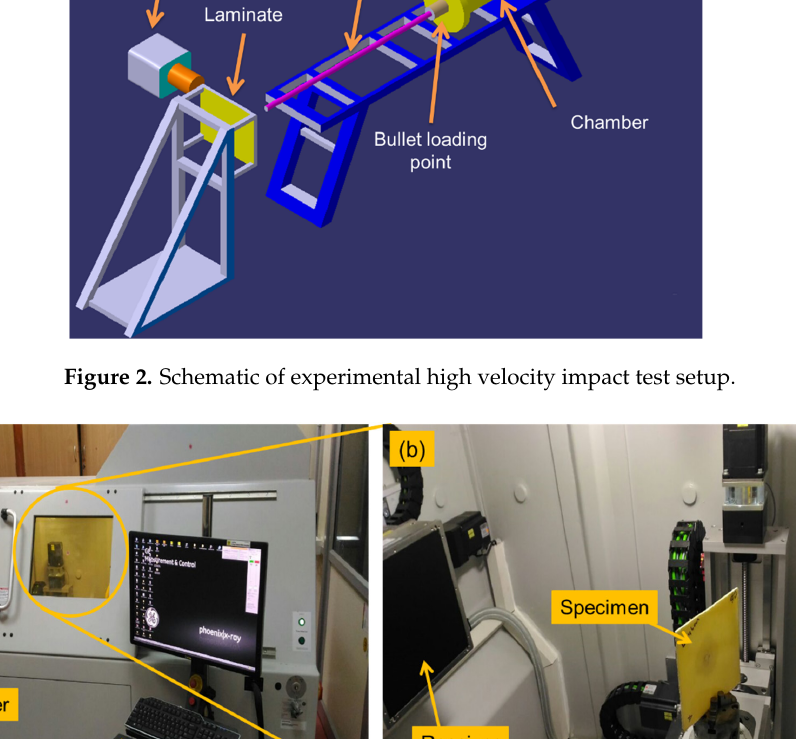
Figure 4. High-velocity camera images taken during the high-velocity impact test. ( a ) Projectile from barrel, ( b ) Projectile hitting the target, ( c ) Projectile piercing out of the target, ( d , e ) Projectile leaving the target. 3. Results and Discussion 3.1. Tensile, Flexural, Impact and ILSS Properties The tensile properties of the laminates are shown in Table 2. The maximum strength of 232 MPa was noted for the composite with 45° fibre orientation, which was 2.5% and 5% higher than those of the composite with 0° and 60° fibre orientations, respectively. The failure strain was higher for the composite with 0° fibre orientation, followed by the 45° and 60° fibre orientation. A maximum failure strain of 1.3% was noted for the composite with 0° fibre orientation, which was 6% and 55% higher than the composite 45° and 60° fibre orientation. The tensile modulus of the composites was higher for the composite with